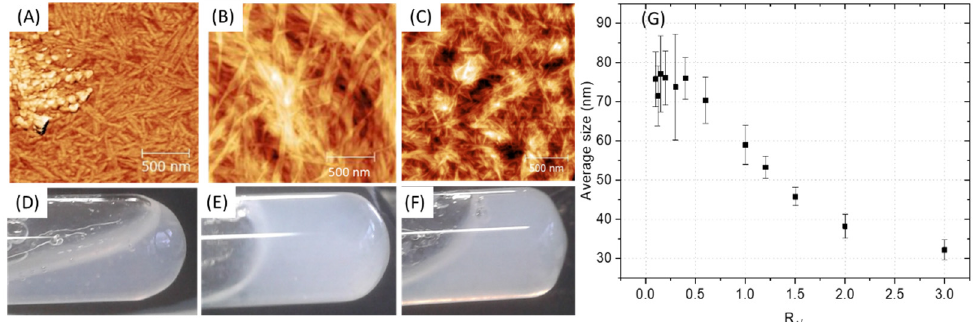
Figure 4. ( A – C ) AFM of PA-PSSNa mixtures at different ratios of PA (+) charges/polymer ( − ) charges (R +/ − ). ( D – F ) Digital photographs of the PA-polymer gels. ( A , D ): R +/ − = 1/3. ( B , E ): R +/ − = 1. ( C , F ): R +/ − = 3. ( G ) Average fibril diameter, estimated by AFM, as a function of the PA (+) charges /polymer ( − ) charge ratios (R +/ − ), standard deviation.